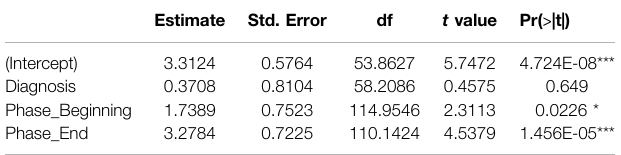
TABLE 1 | Coef fi cient table to probe the effect of the depression diagnosis and phase of the conversation (the middle phase was chosen as the baseline category) on SC response rates. The marginal R 2 for the model was 0.10 and the conditional R 2 was 0.19. Estimate Std. Error df